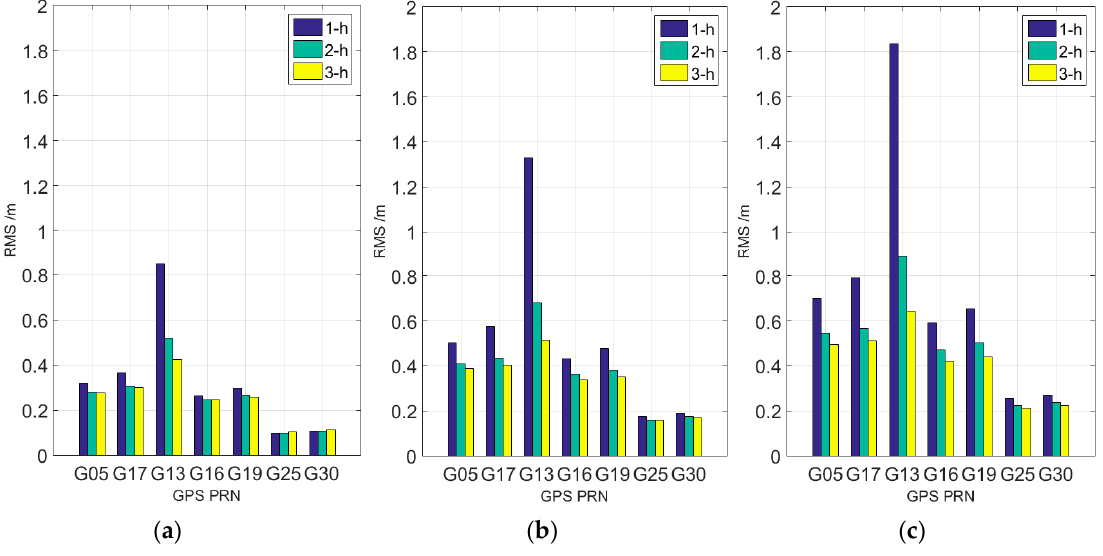
Figure 6. Comparison of 1-h prediction ( a ), 2-h prediction ( b ) and 3-h prediction ( c ) results based on different lengths of observations.